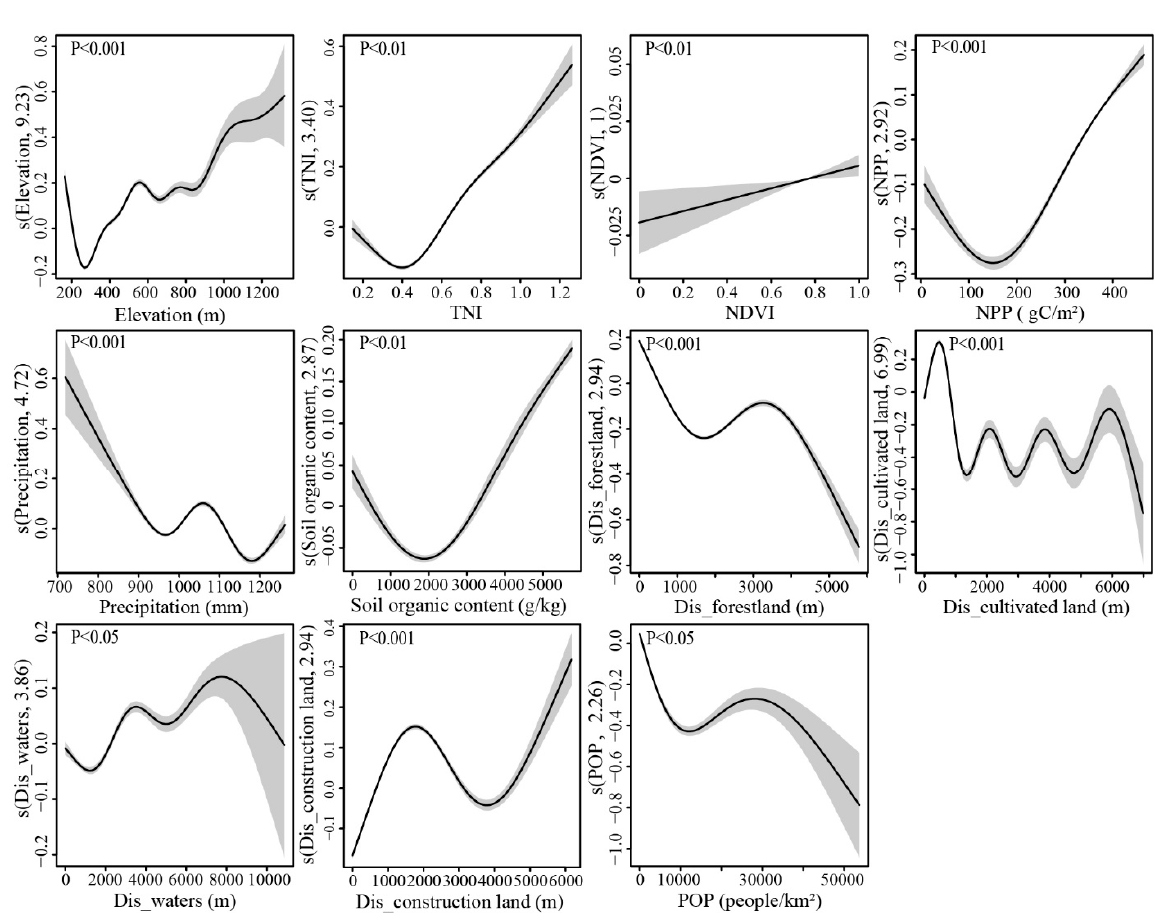
Figure 10. Smoothing functions of the covariate terms for biodiversity GAM showing the effect of driving factors.